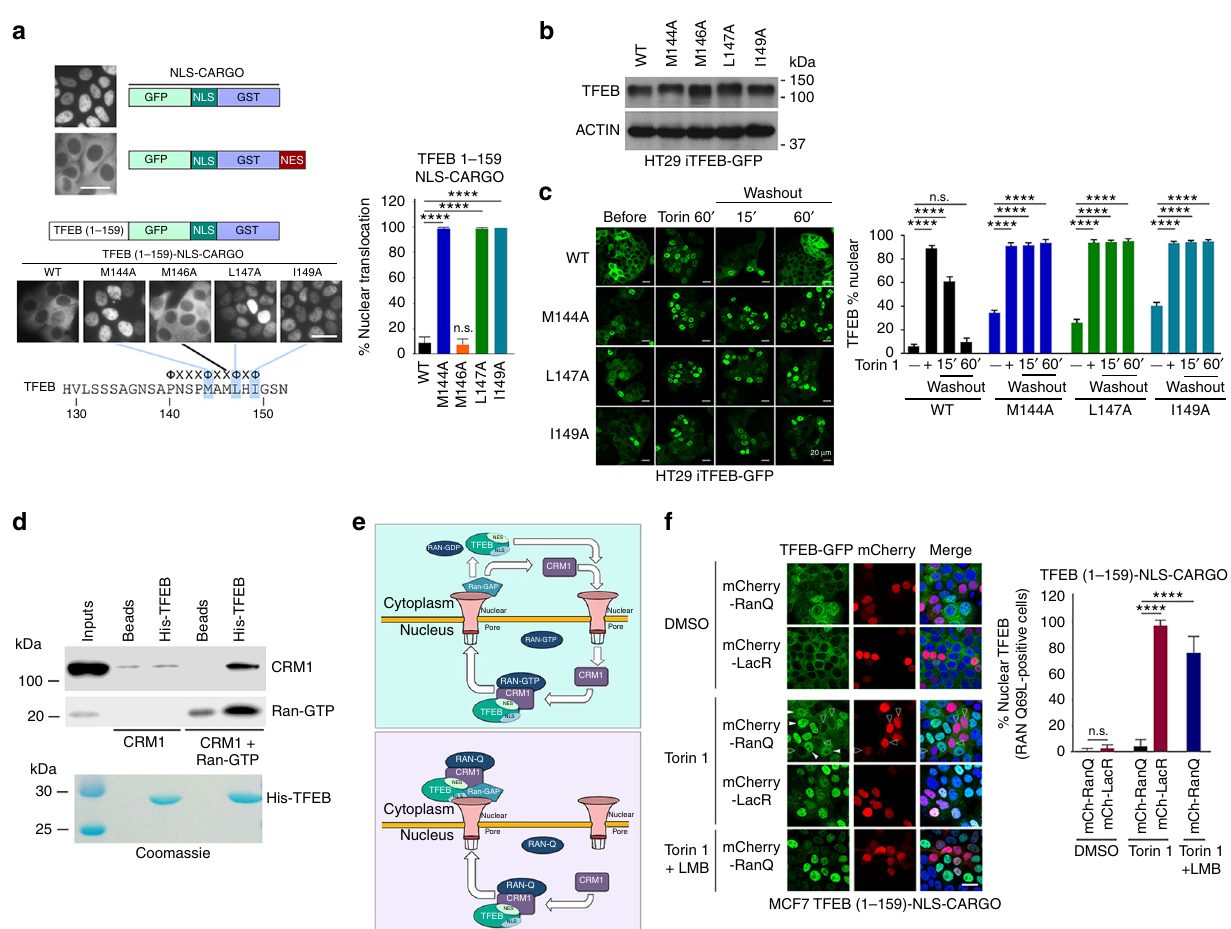
Fig. 3 TFEB is subject to CRM1-mediated nuclear export. a Live cell steady state images of indicated cargo vectors stably expressed in MCF7 cells. n > 120 cells per condition. b Western blot of HT29 cells expressing doxycycline-inducible WT or indicated mutant TFEB-GFP ( − Dox). c Fluorescence images of HT29 cells stably expressing indicated WT and mutant TFEB-GFP treated with Torin 1 (25 nM) for 1 h before cells were washed and placed in Torin 1-free medium for 15 or 60 min. n > 300 cells per condition. d Western blot using indicated antibodies to detect CRM1 and RAN after pull down of immobilized HIS-tagged TFEB (aas 1 – 200). All proteins were bacterially expressed and puri fi ed. Puri fi ed TFEB was visualized by Coomassie staining (lower panel). e Schematic depicting the role of CRM1 and RAN in nuclear export using TFEB as a potential substrate. Top: RAN-WT; Bottom, RAN-Q69L. See text for details. f Fluorescence images of steady state subcellular localization of MCF7 cells stably expressing the TFEB 1-159-NLS-cargo together with either mCherry-LacR or mCherry RAN-Q69L. Cells were treated with DMSO, Torin 1 (250 nM) alone or with LMB (20 nM) as indicated. Subcellular localization of TFEB-GFP was quanti fi ed for cells expressing mCherry. n > 100 cells per condition. In the RanQ experiment, only mCherry positive cells were counted. Scale bars = 20 μ M. Error bars = SD. Student ’ s t -test; **** P < 0.0001, n.s. not signi